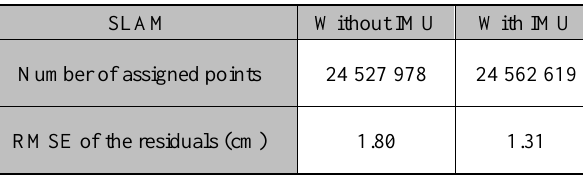
Table 2. The number of assigned points and the corresponding RMSEs of the